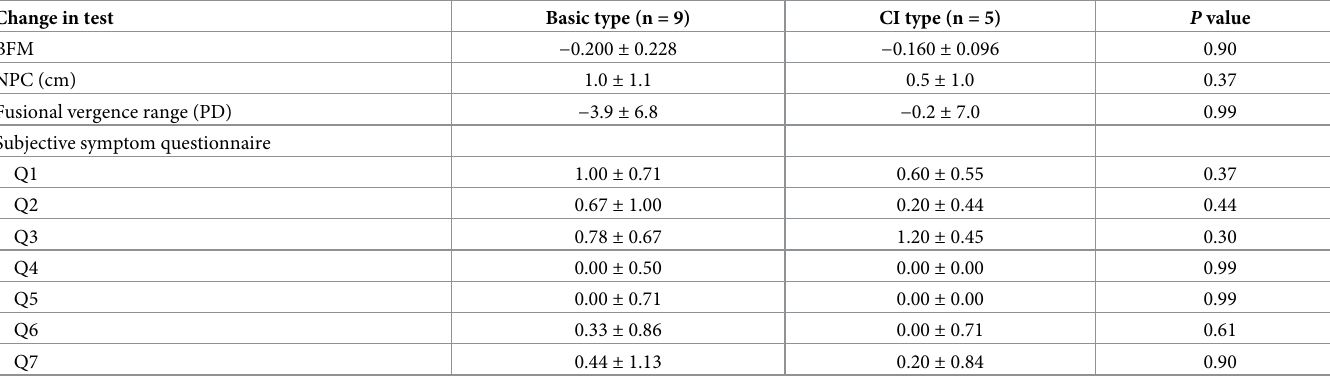
Table 5. Mean results for the intermittent exotropia (IXT)